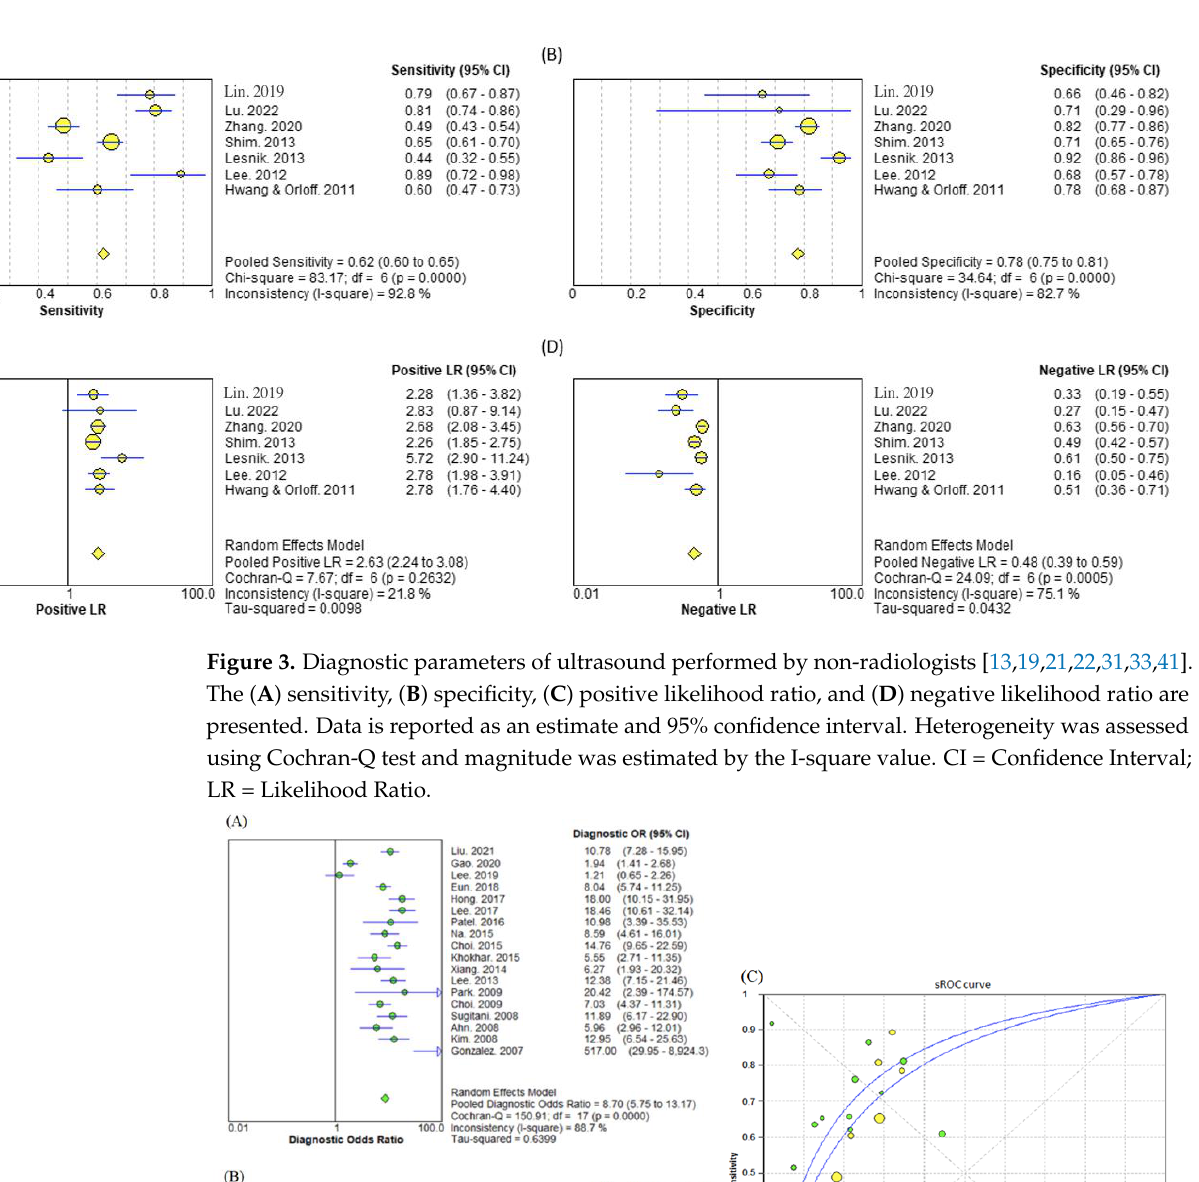
Figure 2. Diagnostic parameters of ultrasound performed by radiologists [18,20,22 – 30,32,34 – 39]. The ( A ) sensitivity, ( B ) specificity, ( C ) positive likelihood ratio, and ( D ) negative likelihood ratio are presented. Data is reported as an estimate and 95% confidence interval. Heterogeneity was assessed using Cochran-Q test and magnitude was estimated by the I-square value. CI = Confidence Interval; LR = Likelihood Ratio.